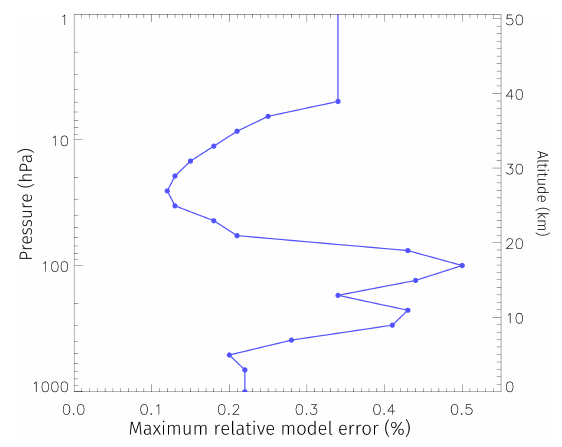
Figure 3. Maximum relative model error ( a ) as a fraction of the partial column at different altitudes.